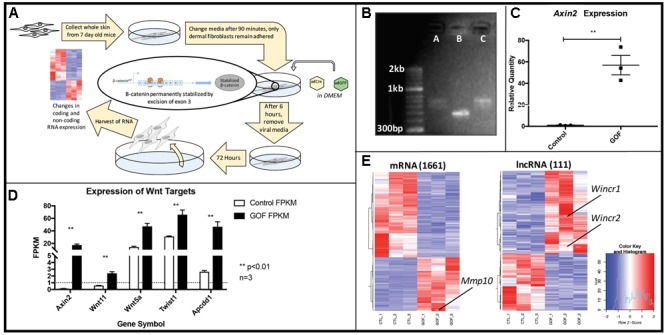
In vitro genetic recombination of β-catenin (Ctnnb1Δex3) in dermal fibroblasts results in a strong Wnt signaling expression signature as well as global expression changes in coding and non-coding genes. (A) Schematic of the workflow (B)
Ctnnb1Δex3 recombination by Adenovirus-Cre (AdCre) infection was confirmed by Ctnnb1 exon3 site-specific PCR in lanes A and C, compared to the control lane B, infected with Adenovirus-GFP. (C) Relative mRNA quantity of Axin2, a direct β-catenin target is significantly higher in β-catenin stabilized gain of function dermal fibroblasts (GOF) (P-value = 0.0035, n = 3). (D) Known β-catenin targets are higher in GOF dermal fibroblasts by RNAseq (n = 3). (E) Heat map showing hierarchical clustering (based on entities and samples) of all differentially expressed mRNAs (1661) and lncRNAs (111) (P-value < 0.05, fold change > 2) in response to β-catenin stabilization.